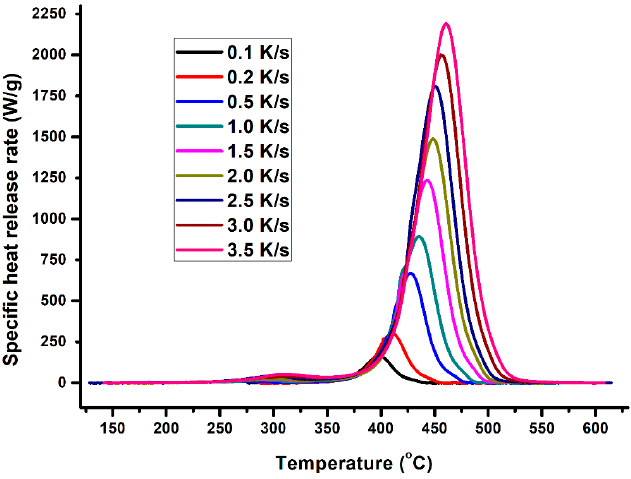
Figure 2. Plot of specific heat release rate versus temperature.